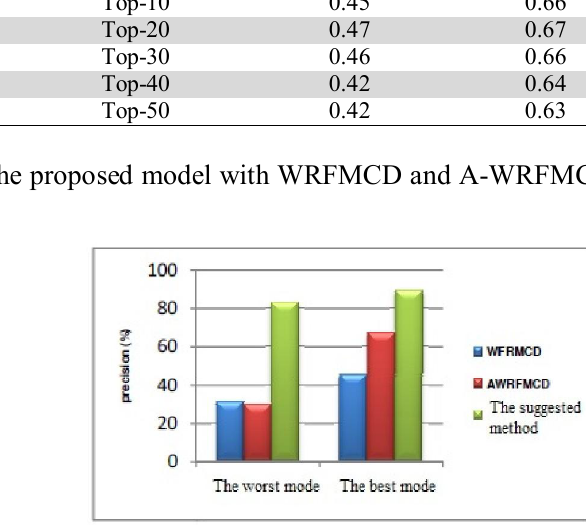
Fig. 2. A comparison of the ‘precision’ value from the suggested method and that of the methods ‘WRFMCD’